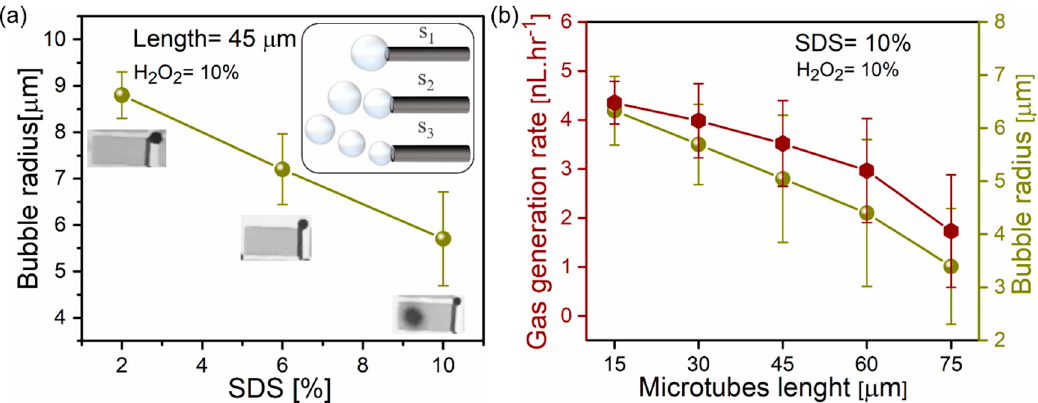
Figure 4. ( a ) Dependence of bubble radius and SDS surfactant concentration using constant tubular length (45 µm ) and hydrogen peroxide concentration (10%). Insets are optical microscopy images indicating O 2 bubbles detachment at different frequencies induced by the change of SDS concentrations 2, 6, 10% v/v, respectively. ( b ) Total oxygen generation and average bubble radius for 15, 30, 45, 60 and 75 µm long microtubes immersed in 10% SDS, 10% H 2 O 2 solution. Higher temperature increases rates of hydrogen peroxide decomposition in the presence of a palladium catalyst. Figure 5 shows the temperature effect on the 45 µm long catalytic microtubes in 10% v/v surfactant and 1% v/v and H 2 O 2 solution. Figure 5a is the optical micrograph of oxygen bubble generation at a temperature of 35 °C using 45 µm long tubes in 1% v/v peroxide and 10% v/v SDS. Subsequently, the temperature is set to 10, 15, 20, 25, 30, 35 °C to calculate the oxygen generation rates, as shown in Figure 5b. Less oxygen is generated at lower temperatures, i.e., 1.3 and 18.1 nL·hr − 1 at 10 and 15 °C, correspondingly. The dramatic increase in oxygen generation is obtained from at higher temperatures, i.e., 20 and 35 °C, which is 52.6 to 290.91 nL·hr − 1 , correspondingly. Furthermore, bubble frequencies are increased from 5.1 to 28.1 Hz in 10–35 °C temperature range. Previously, the superfast motion of Ti/Cr/Pt microtubes was observed in similar conditions by increasing the temperature of the hydrogen peroxide solution [28]. These parameters enable the generation of oxygen at lower levels of hydrogen peroxide, i.e., more efficient bubble nucleation/generation, and achieve significantly higher oxygen rates by a relatively negligible change of solution temperature. Generally, temperature increases the rate of reaction due to a larger number of the colliding hydrogen peroxide molecules with the catalyst surface, which have required activation energy leading to more successful collisions for decomposition reaction to occur. Despite the reaction simplicity, many intermediate compounds can form and multiple elementary steps must be considered for better understanding of H 2 O 2 decomposition over the Pd surface, for which we reserve our future study.